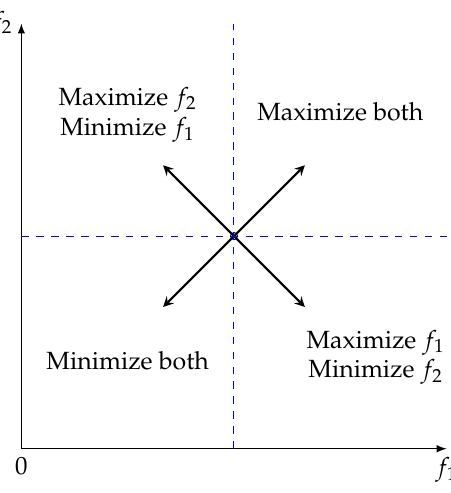
Figure 4. Search directions in multi objective